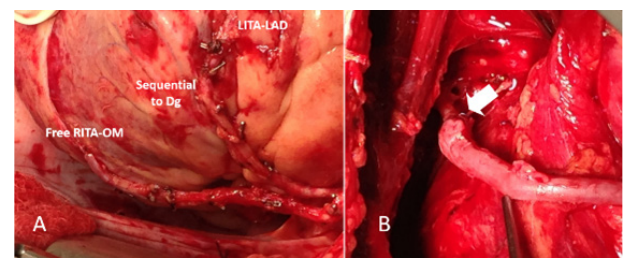
Fig. 3 - A. Left internal thoracic artery (LITA) sequentially grafted to left anterior descending coronary artery (LAD) and diagonal. Free right internal thoracic artery (RITA) to obtuse marginal (OM) connected to LITA in a Y-fashion. B. The saphenous vein graft to posterior descending coronary artery sutured end-to-end to the RITA stump (white arrow). Dg=diagonal artery.